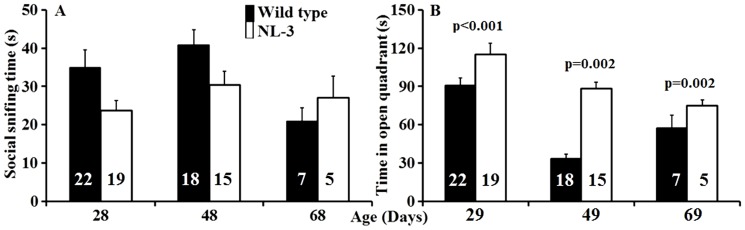
Bar graphs from the NL-3 knock-in and wild type littermates showing average social sniffing time (time spent by the test animal sniffing the stimulus mouse) at 3 different ages (A).Social sniffing test demonstrated significant differences at each time points between wild type and NL-3 mice (p = 0.019) based on a linear mixed effects model adjusting for gender and age and with no significant group interaction. Bar graph showing the average time spent by the animals in the open quadrant of the zero maze test in wild type littermates and NL-3 knock-in mice (B). Longer time spent in the open quadrants is thought to reflect lower anxiety-related behavior. Significant differences in anxiety scores were observed between wild type and NL-3 mice at each time point after adjusting for gender and age using a linear mixed effect model. A significant group interaction was also observed in anxiety score (p<0.05) based on a liner mixed effects model adjusting for gender and age. The numbers inside each bar show the number of animals while the error bars represent SEM.